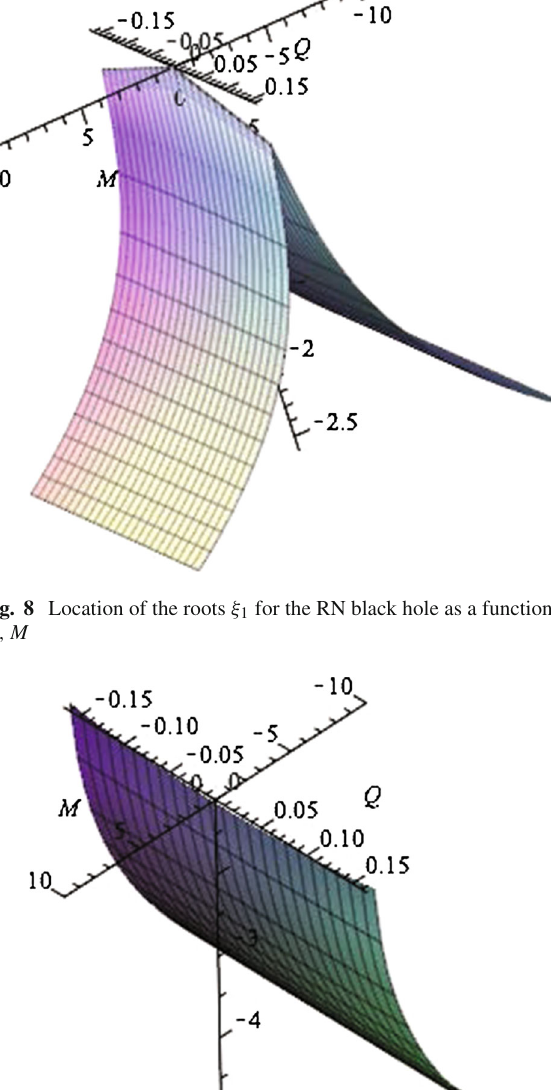
Fig. 11 P – V diagram for the thermodynamic volume V = 4